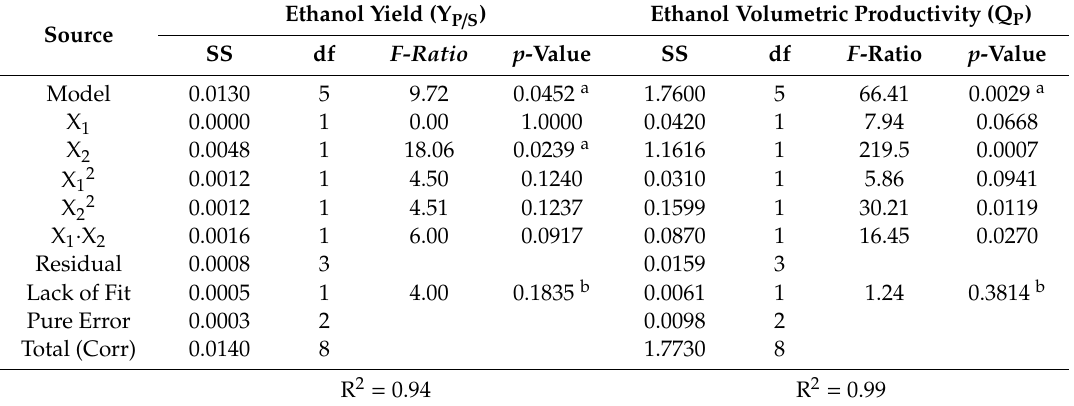
Table 6. Analysis of variance (ANOVA) of the quadratic models for ethanol yield and volumetric productivity in batch mode SSF of pre-treated rice straw in the VBM reactor.